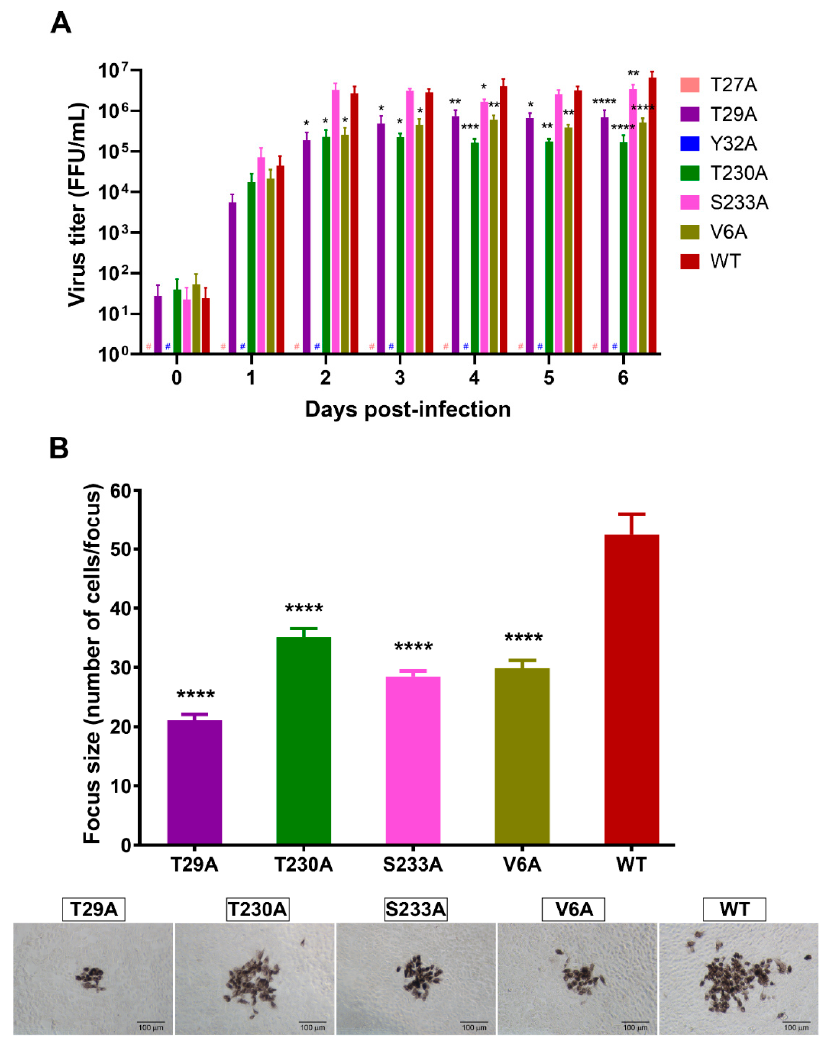
Figure 7. Effects of phosphorylation site mutations of DENV NS1 on DENV production and virus-infected cell foci. Vero cells were infected with wild-type DENV or different virus mutants, and culture supernatants were collected at the indicated time points post-infection to determine infectious DENV by FFU assay. ( A ) Production of infectious DENV in virus-infected cultures was reported as virus titers (FFU/mL). ( B ) The size of virus-infected cell foci following infection with wild-type DENV or different virus mutants was enumerated based on the number of DENV E-expressing cells per focus in the FFU assay. Approximately 101–134 virus-infected cell foci were analyzed, and their representative images are shown (bottom panel). The results in ( A , B ) demonstrate the mean ± SEM of four independent experiments (* p < 0.05; ** p < 0.01; *** p < 0.001; **** p < 0.0001; #no detectable DENV titers).